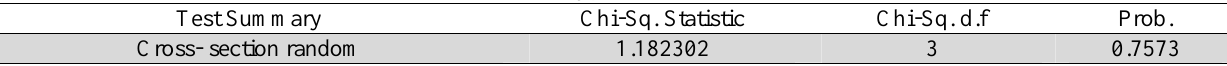
Correlated Random Effects- Hausman Test of Hypothesis 2